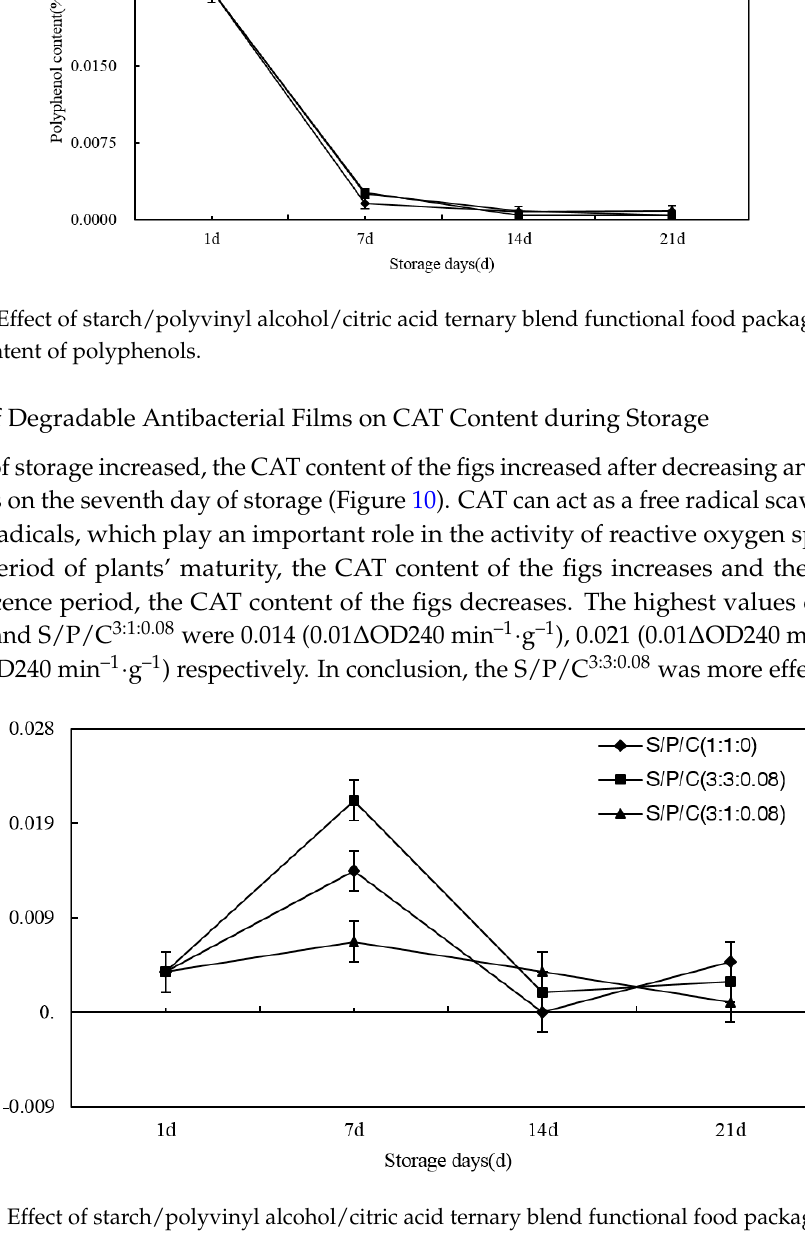
Figure 8. Effect of starch/polyvinyl alcohol/citric acid ternary blend functional food packaging films antibacterial and degradable film on reducing sugar.